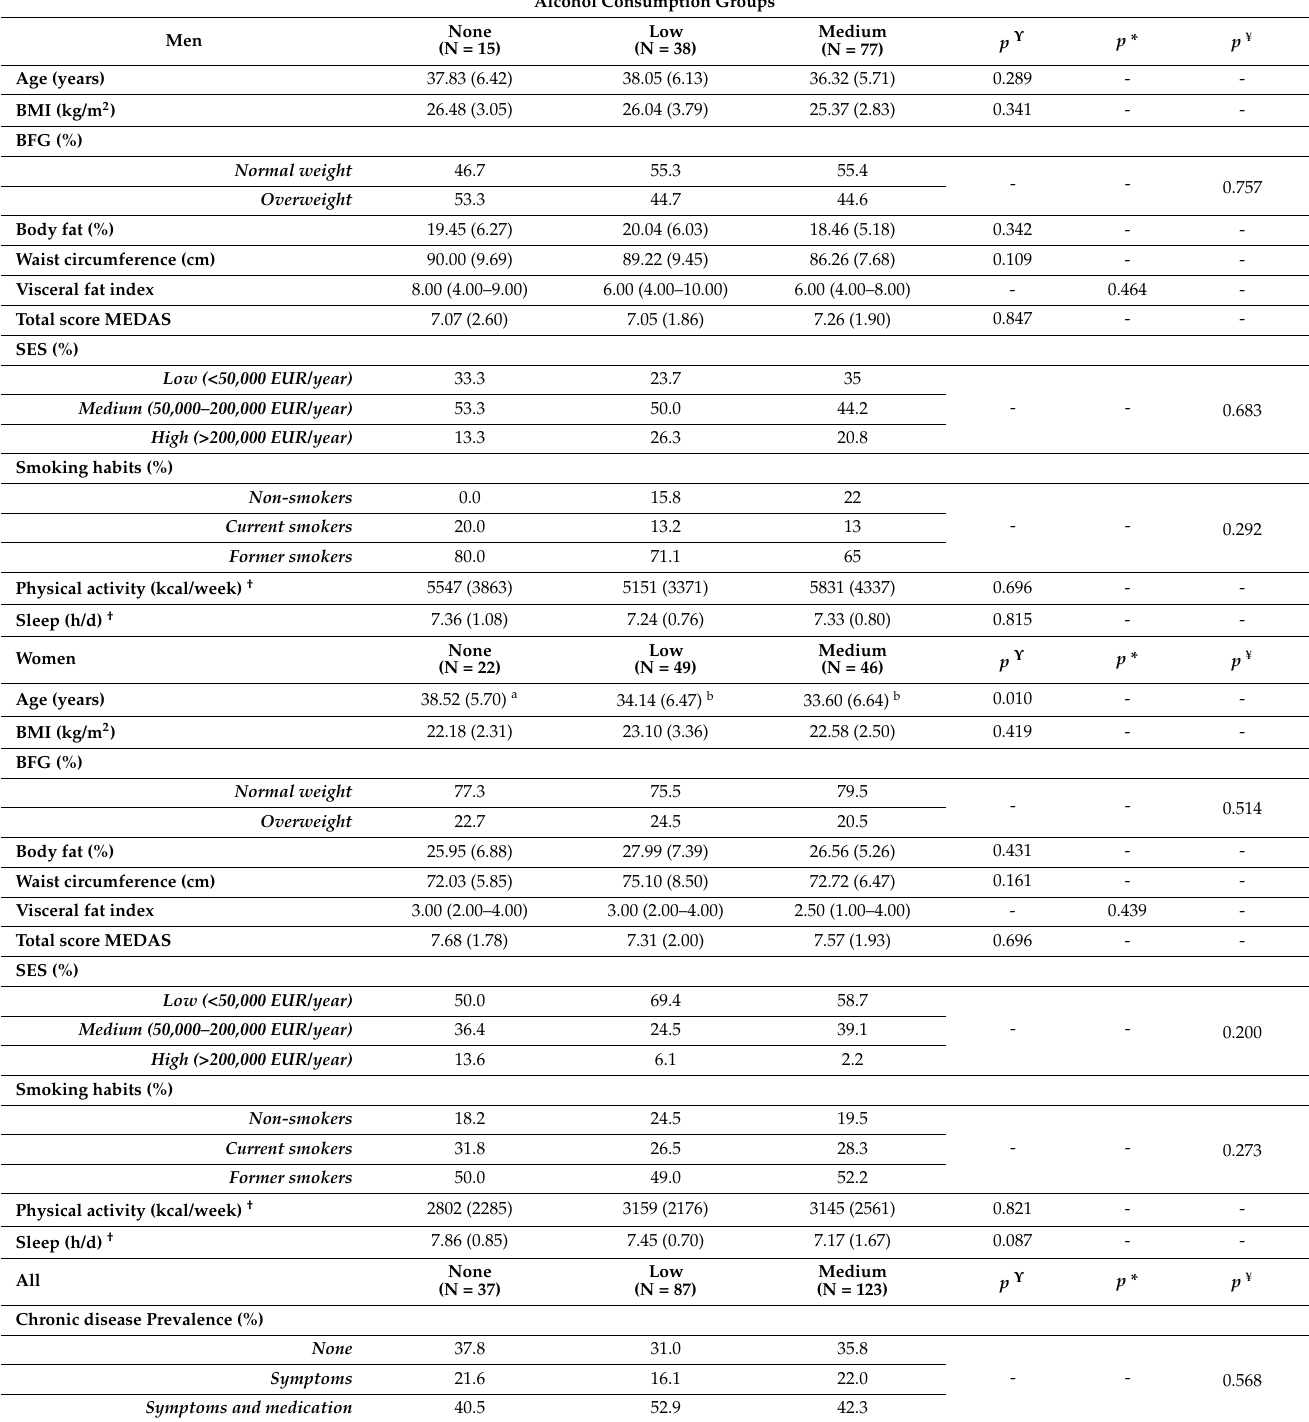
Table 1. Demographic, anthropometric and lifestyle characteristics of the different alcohol con- sumption groups stratified by sex.